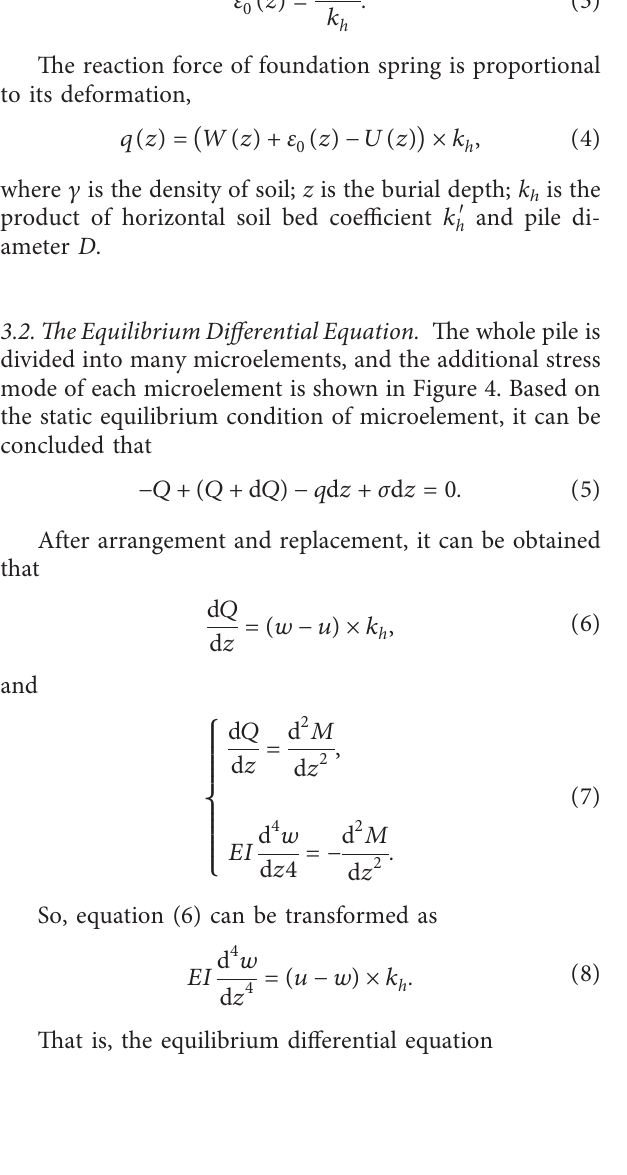
Figure 4: The microelement of